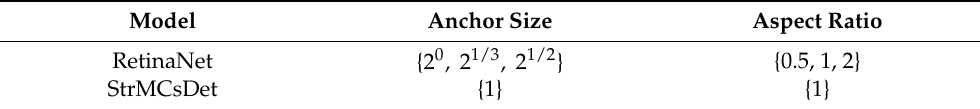
Figure 7. Positive anchors in Strengthen Matching and Max-IoU method. Large ground truth boxes affect the Max-IoU cause imbalance. Ours tend to match different scales equally with the box matching method. Table 1. Anchor size and aspect ratio of RetinaNet and StrMCsDet.